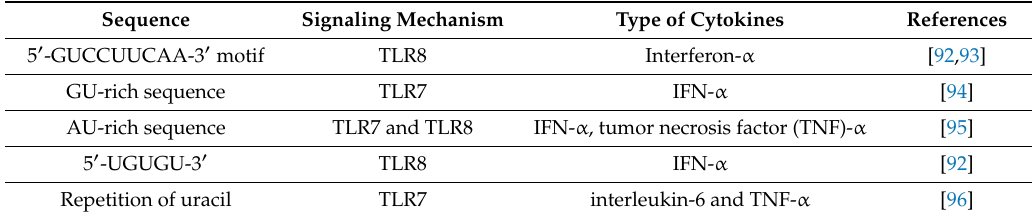
Table 4. TLR-dependent signaling in response to siRNA